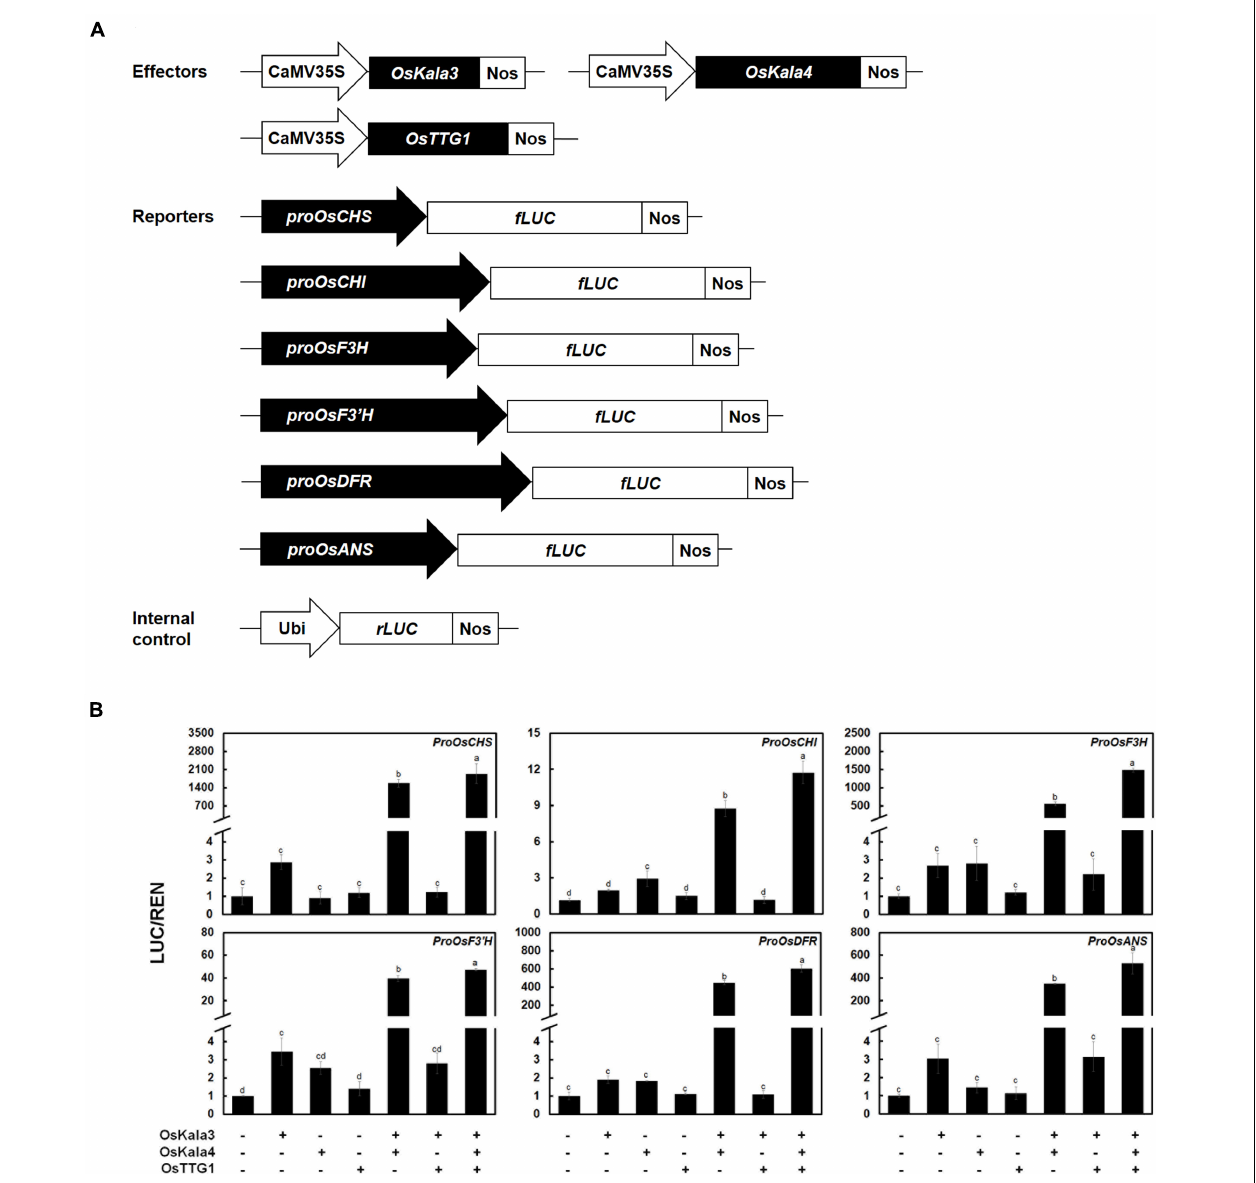
FIGURE 4 | OsKala3, OsKala4, and OsTTG1 cooperate to induce the expression of anthocyanin biosynthetic genes. (A) Schematic representation of effector and reporter constructs used in the transcriptional activation assay. Effector constructs consist of the OsKala3 , OsKala4 , and OsTTG1 open reading frames (ORFs) driven by the CaMV 35S promoter. In the reporter constructs, the firefly luciferase ( fLUC ) reporter gene is driven by the OsCHS , OsCHI , OsF3H , OsF3’H , OsDFR , or OsANS promoters. In the internal control constructs, the Renilla luciferase ( rLUC ) reporter gene is driven by the ubiquitin promoter. (B) Transactivation reporter assays showing the effects of OsKala3, OsKala4, and OsTTG1 on the transcription of anthocyanin biosynthetic genes. Results represent mean values ± SD from three independent biological replicates. Different letters above the bars indicate significantly different values ( p < 0.0001) calculated using one-way ANOVA followed by a Duncan’s multiple-range